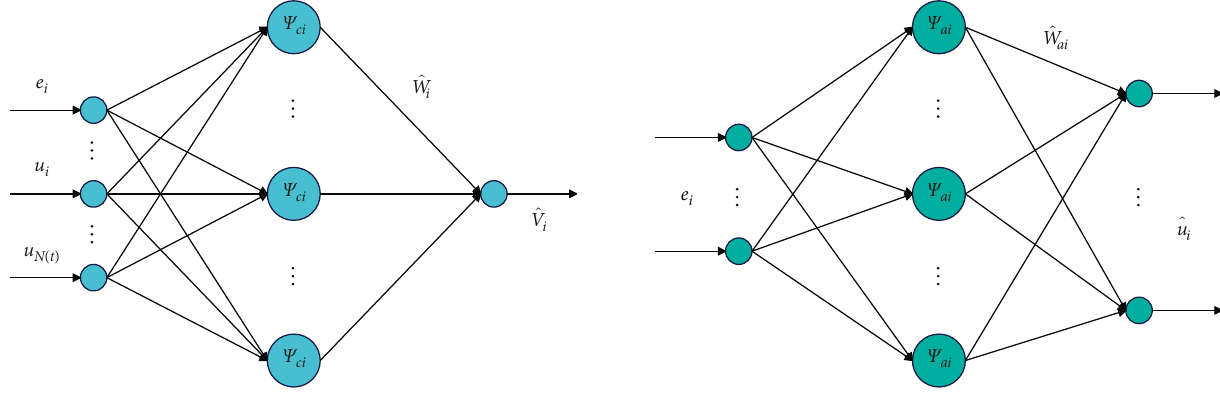
Figure 1: Critic network. Figure 2: Actor